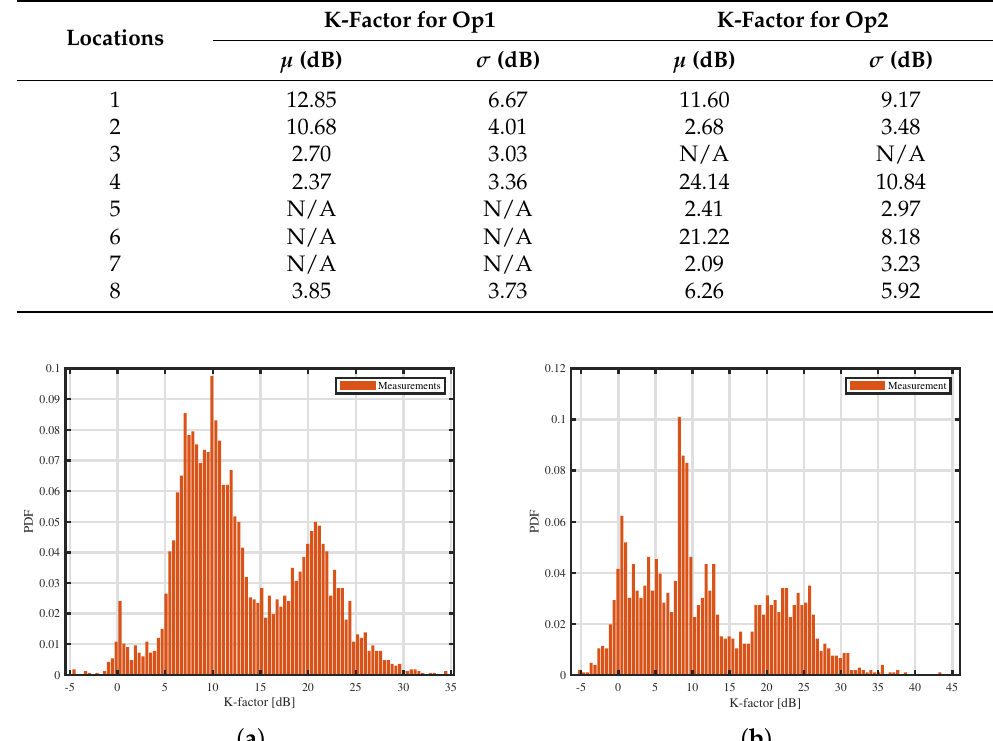
Figure 14. CDF of K-factor for Op1 and Op2 at the measurement location 1 ( a ) Op1 ( b ) Op2. Table 6. K-factor results for Op1 and Op2.